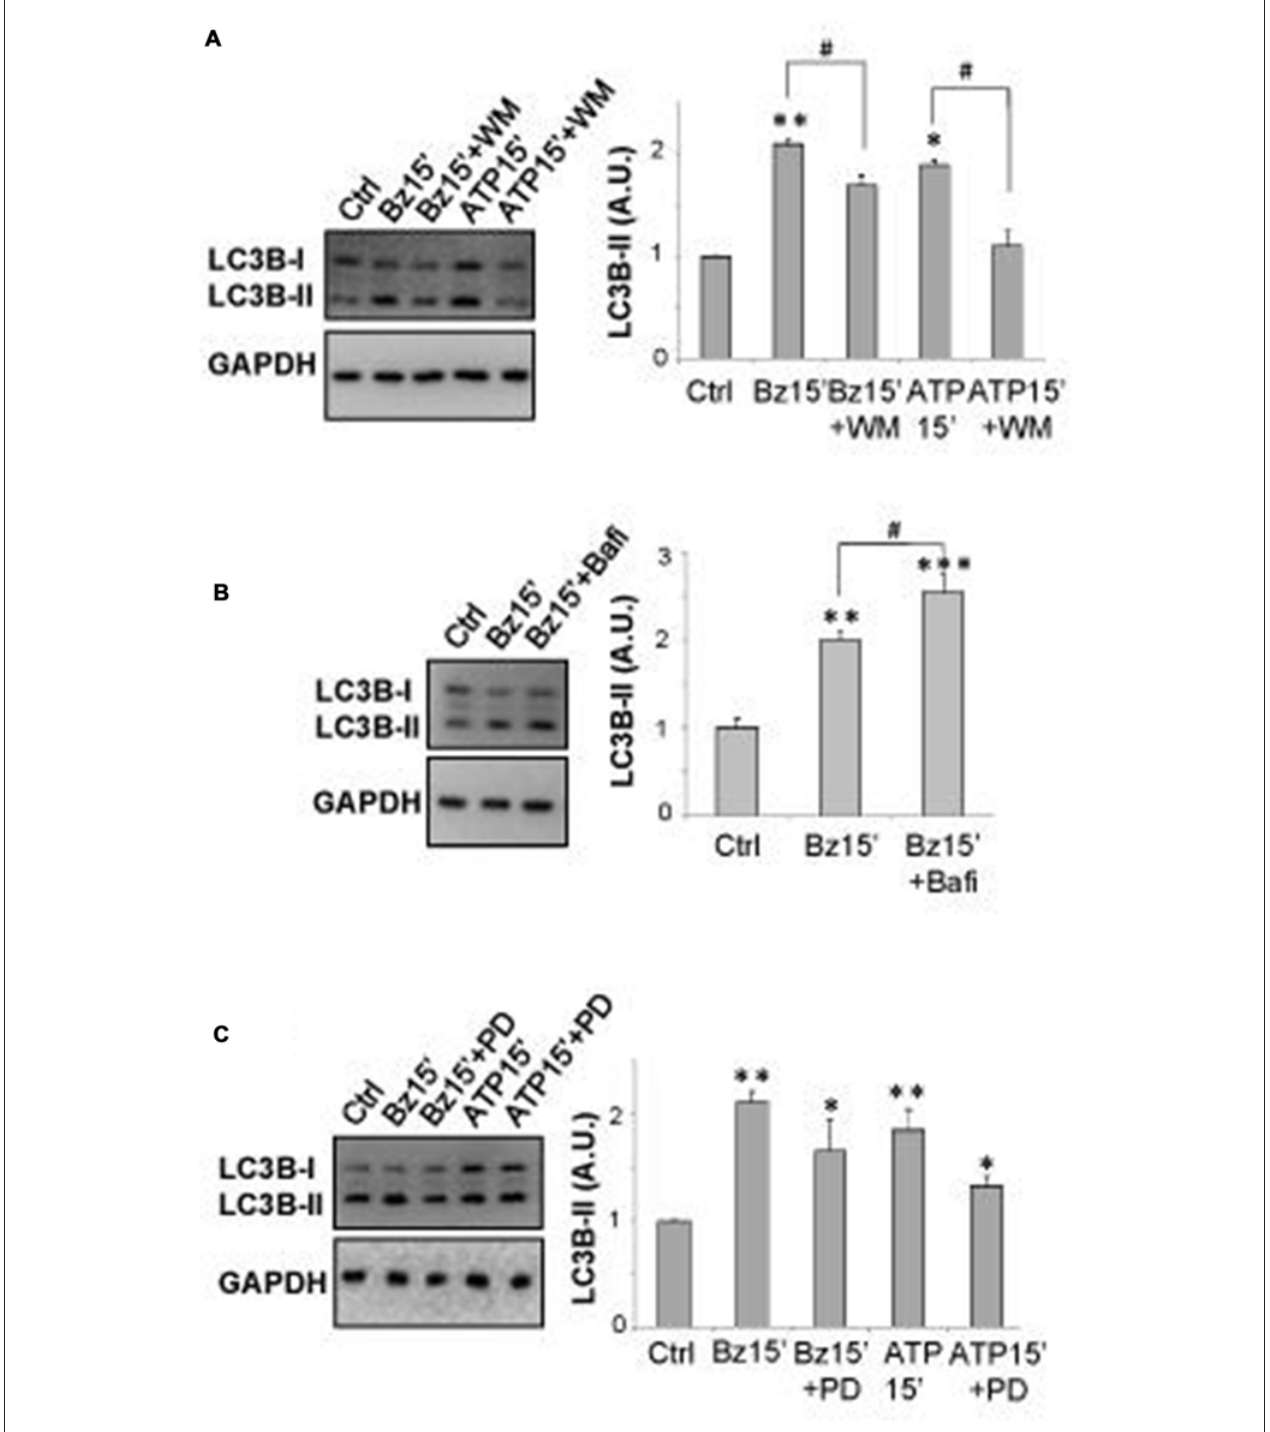
FIGURE 2 | P2X7 induces autophagic flux in SOD1-G93A microglia. Equal amounts of protein from SOD1-G93A primary microglia were subjected to western blotting and immunoreactions with anti-LC3B-II and anti-GAPDH. In (A) SOD1-G93A microglia were treated for 15 min with 300 µ M BzATP or 3 mM ATP in the absence or presence of 100 nM wortmannin (WM) (A) . In (B) SOD1-G93A microglia were treated for 15 min with 300 µ M BzATP in the absence or presence of 25 nM Bafilomycin-A1. (C) SOD1-G93A microglia were treated for 15 min with 300 µ M BzATP or 3 mM ATP, in the absence or presence of 100 µ M PD98059. Data represent mean ± SEM of n = 3 independent experiments. Statistical significance was calculated by ANOVA followed by Post Hoc Tukey’s test and referred to Ctrl ( ∗ p < 0.05, ∗∗ p < 0.01, ∗∗∗ p < 0.001); to BzATP15’-treated cells or to ATP15’-treated cells ( # p < 0.05).